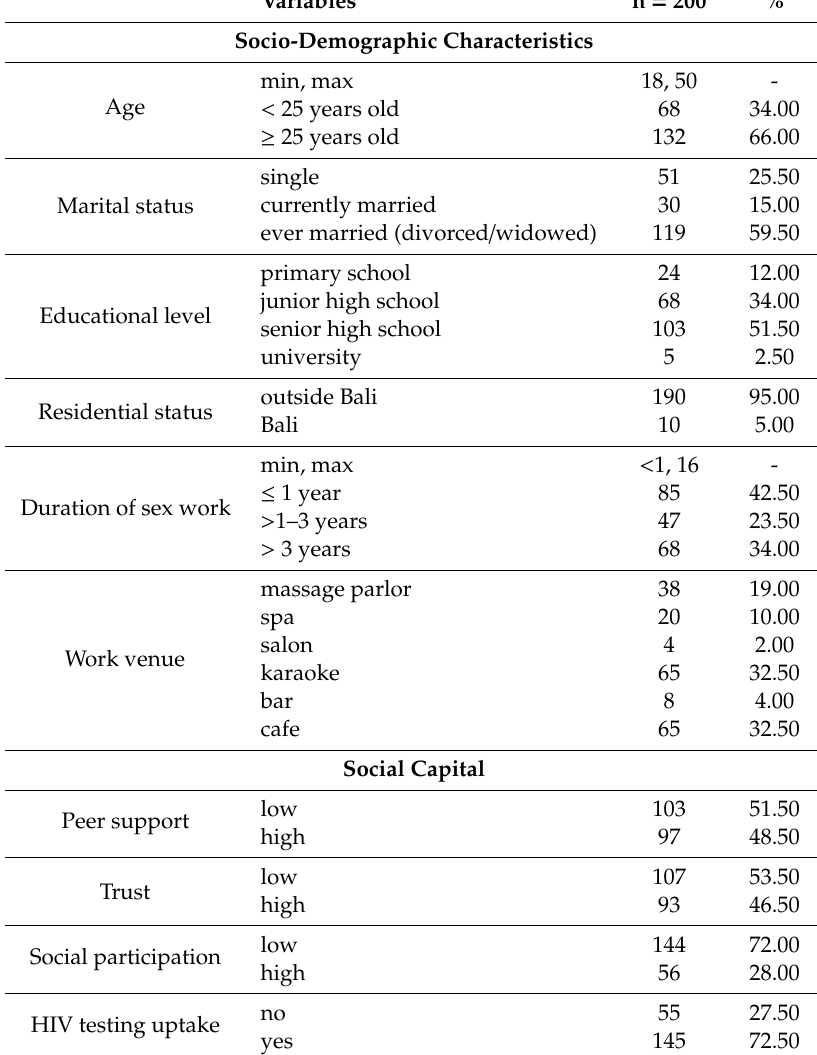
Table 2. Socio-demographic characteristics, social capital, and HIV testing uptake among indirect female sex workers